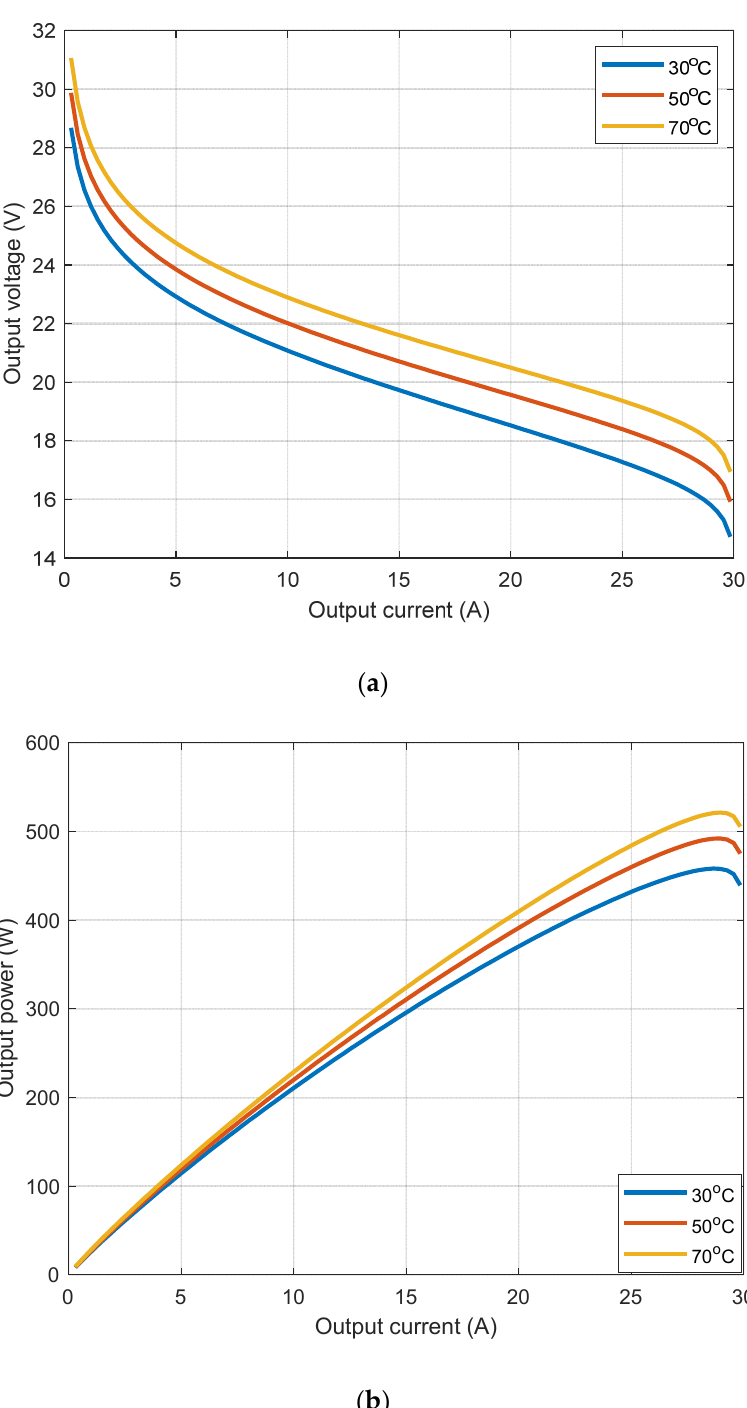
Figure 11. Characteristics of BCS stack under various temperatures: ( a ) current-voltage and ( b ) cur- rent-power.